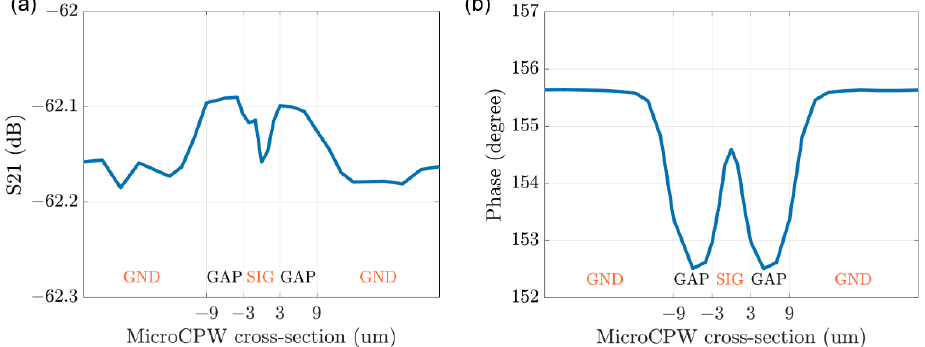
Figure 7. The CST simulation results in the particle at different positions relative to the cross-section of the sensing CPW structure to mimic the process of particle passing through the sensor. ( a ) the magnitude and ( b ) the phase of transmission signal S 21 . The blue solid line and the orange ribbon around it are simulation results and their error range respectively. While the yellow solid line and blue ribbon around it are respectively the mirrored simulation results and their error range of the left half to demonstrate their symmetry with the right half of the simulation results.